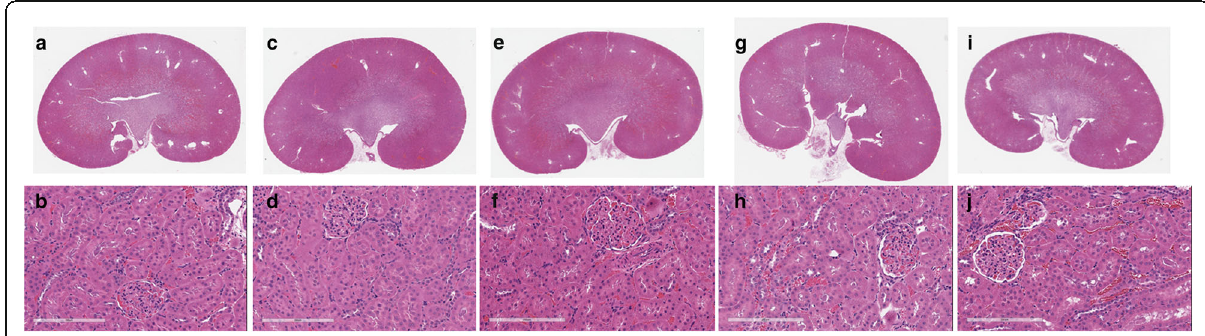
Fig. 2 Representative overviews and high magnifications (bar = 200 μ m) of kidneys from control animals ( a and b ) and from animals administered a total cumulative dose of 12 mmol/kg bodyweight of ProHance ( c and d ), Dotarem ( e and f ), Clariscan ( g and h ), and Gadovist ( i and j ). None of the kidneys showed any histologic